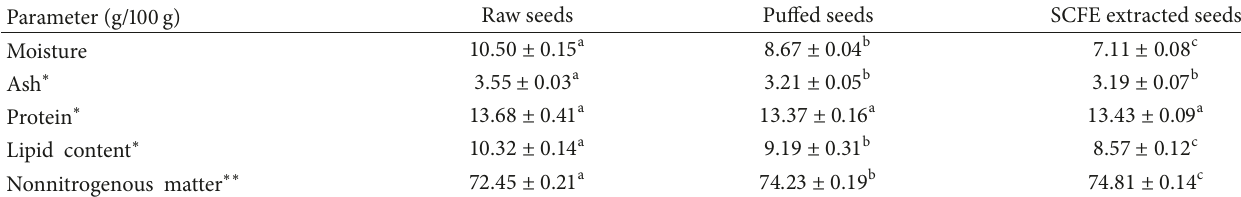
Table 1: Chemical proximal characterization of raw, puffed, and SCFE-extracted A. hypochondriacus seeds.